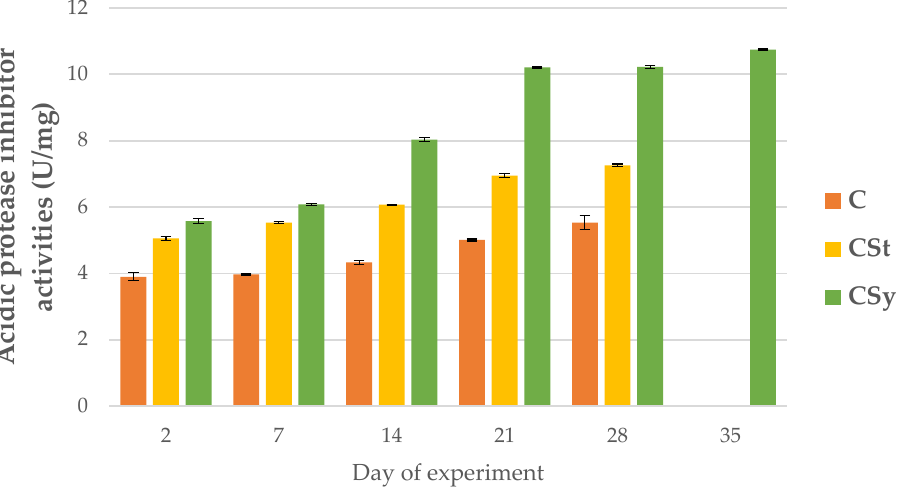
Figure 5. Acidic protease inhibitor activities in the 2, 7, 14, 21, 28, 35-day-old honey bees’ hemolymph after two methods of supplementation with hemp extract: C-control (pure sugar syrup), CSy-hemp extract in syrup, CSt-hemp extract on strips. (Two-Way ANOVA: supplementation method: F (2, 156) = 108.68, p = 0.0000, se ± 0.201107–0.181740; days of supplementation: F (4, 143) = 8449.9, p = 0.0000, se ± 0.013698 – 0.023726; supplementation method × days of supplementation F (8, 143) = 1230.1, p = 0.0000, se ± 0.023726 – 0.025009.